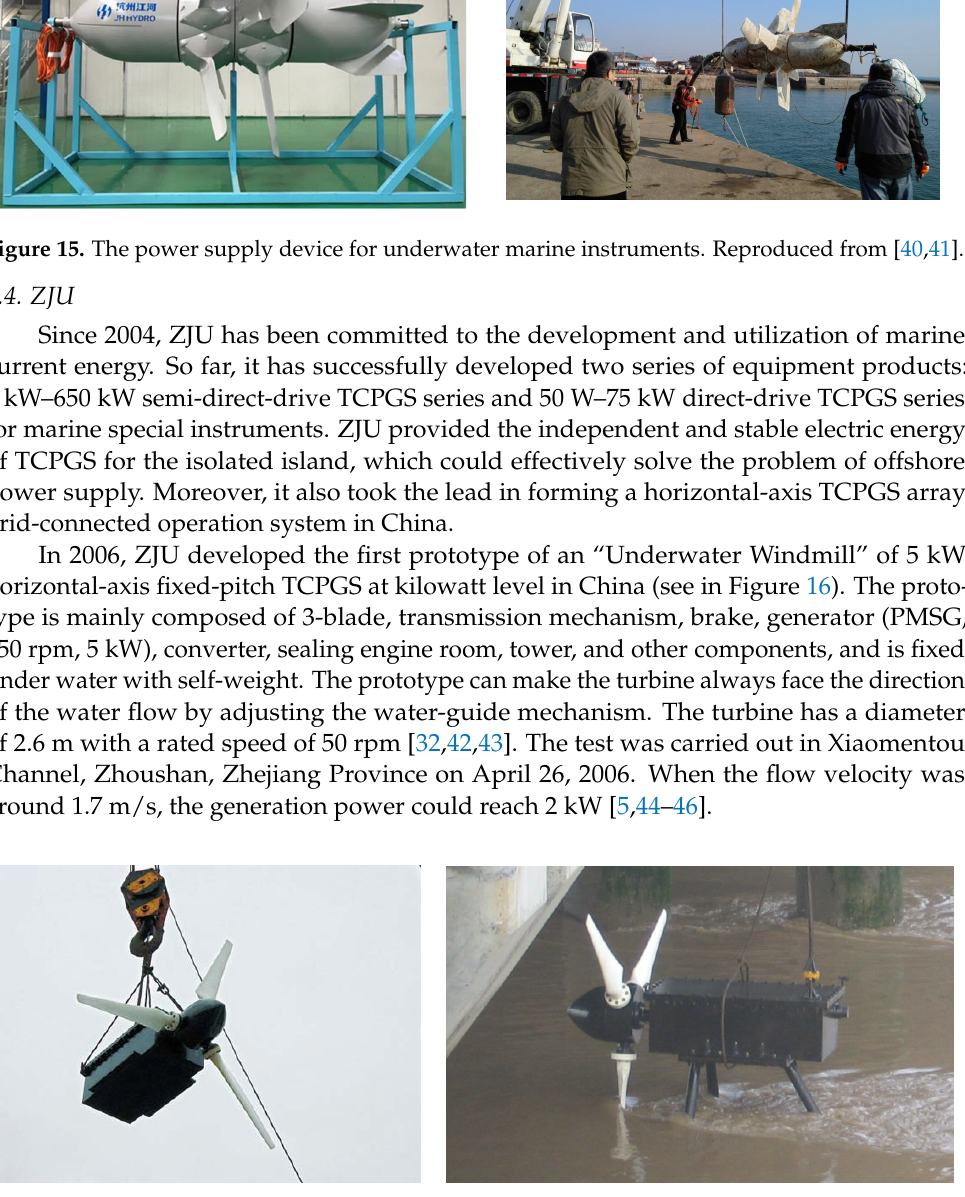
Figure 16. “Underwater Windmill”—5 kW horizontal-axis fixed pitch prototype. Reproduced from [5,45].